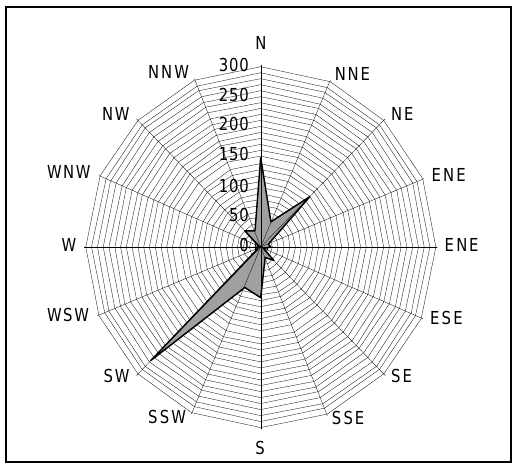
Figure 1. “Wind roses” in Kuršumlija area (RHSS,